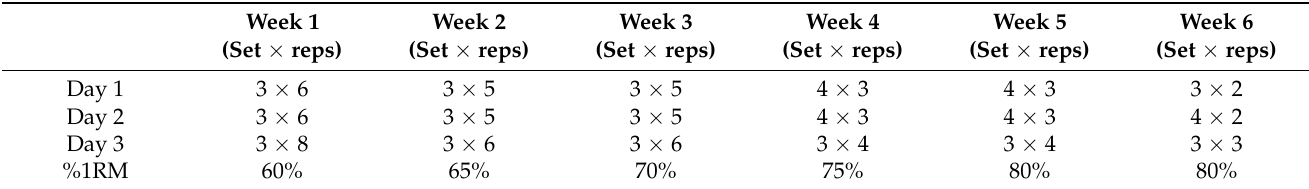
Table 1. Bench press strength intervention program